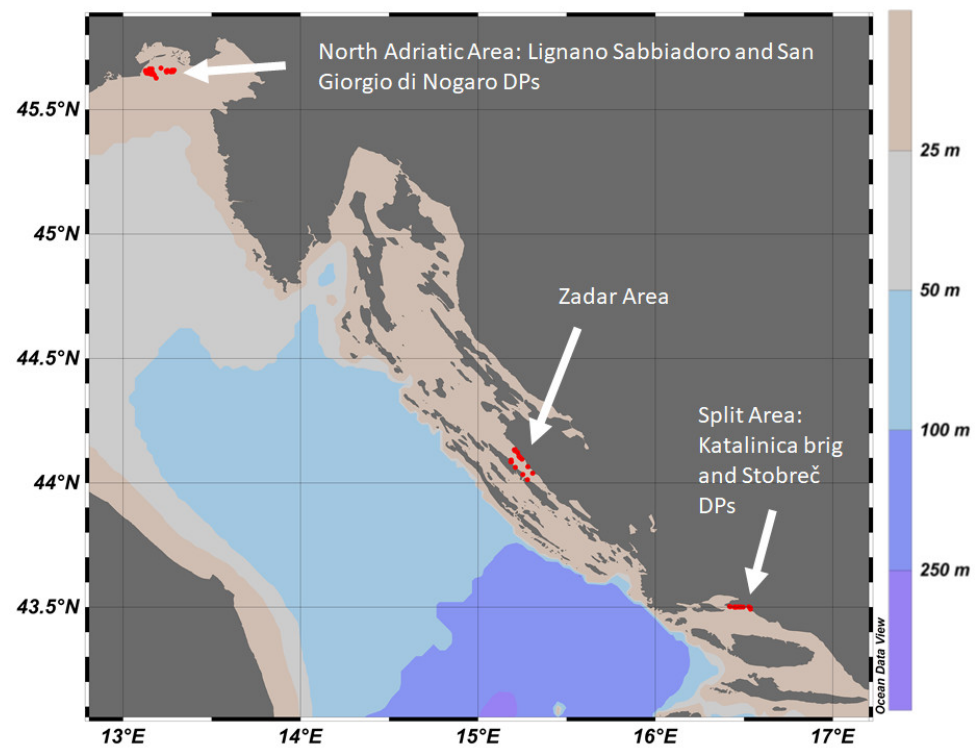
Figure 2. Location of the areas where existing data have been collected for the analyses. Red dots indicate the sampling stations where microbiological samples have been collected.